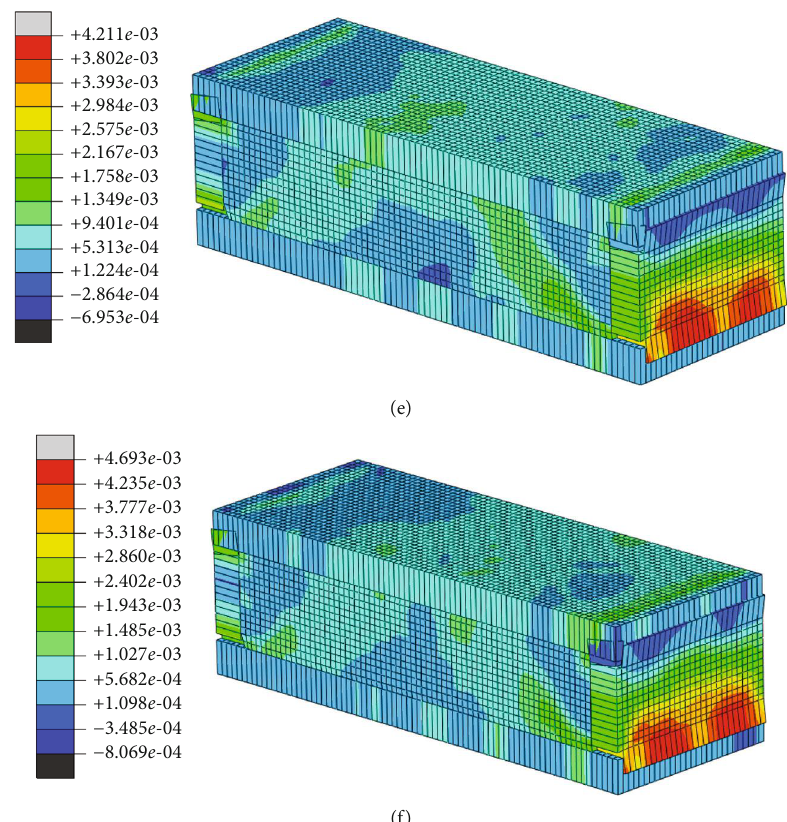
Figure 23: Strain clouds of bird impact battery box at di ff erent angles. (a) 15 ° , (b) 20 ° , (c) 25 ° , (d) 45 ° , (e) 60 ° , and (f) 75 ° .